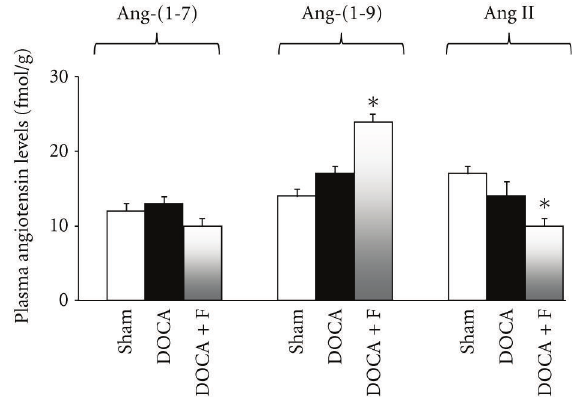
Figure 2: Plasma levels of Ang-(1–7), Ang-(1–9) and Ang II in DOCA salt hypertensive rats treated with the Rho kinase inhibitor fasudil. Increased plasma levels of Ang-(1–9) were observed in DOCA salt hypertensive rats treated with the Rho kinase inhibitor fasudil. Fasudil (100mh/kg/day) by gavage was administered during 3 weeks, starting on the third week after DOCA administration. Data are presented as mean ± SEM ( n = 8–11/group). DOCA: deoxycorticosterone, F: fasudil. ∗ P < 0 . 05 compared to both Sham and untreated DOCA groups (adapted with permission from